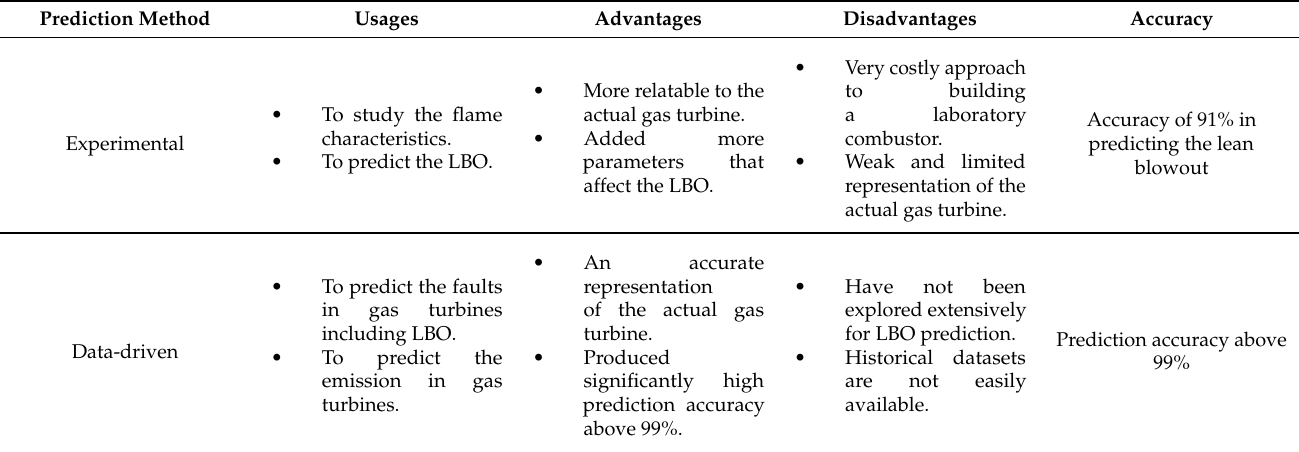
Table 6. Comparison of the LBO prediction